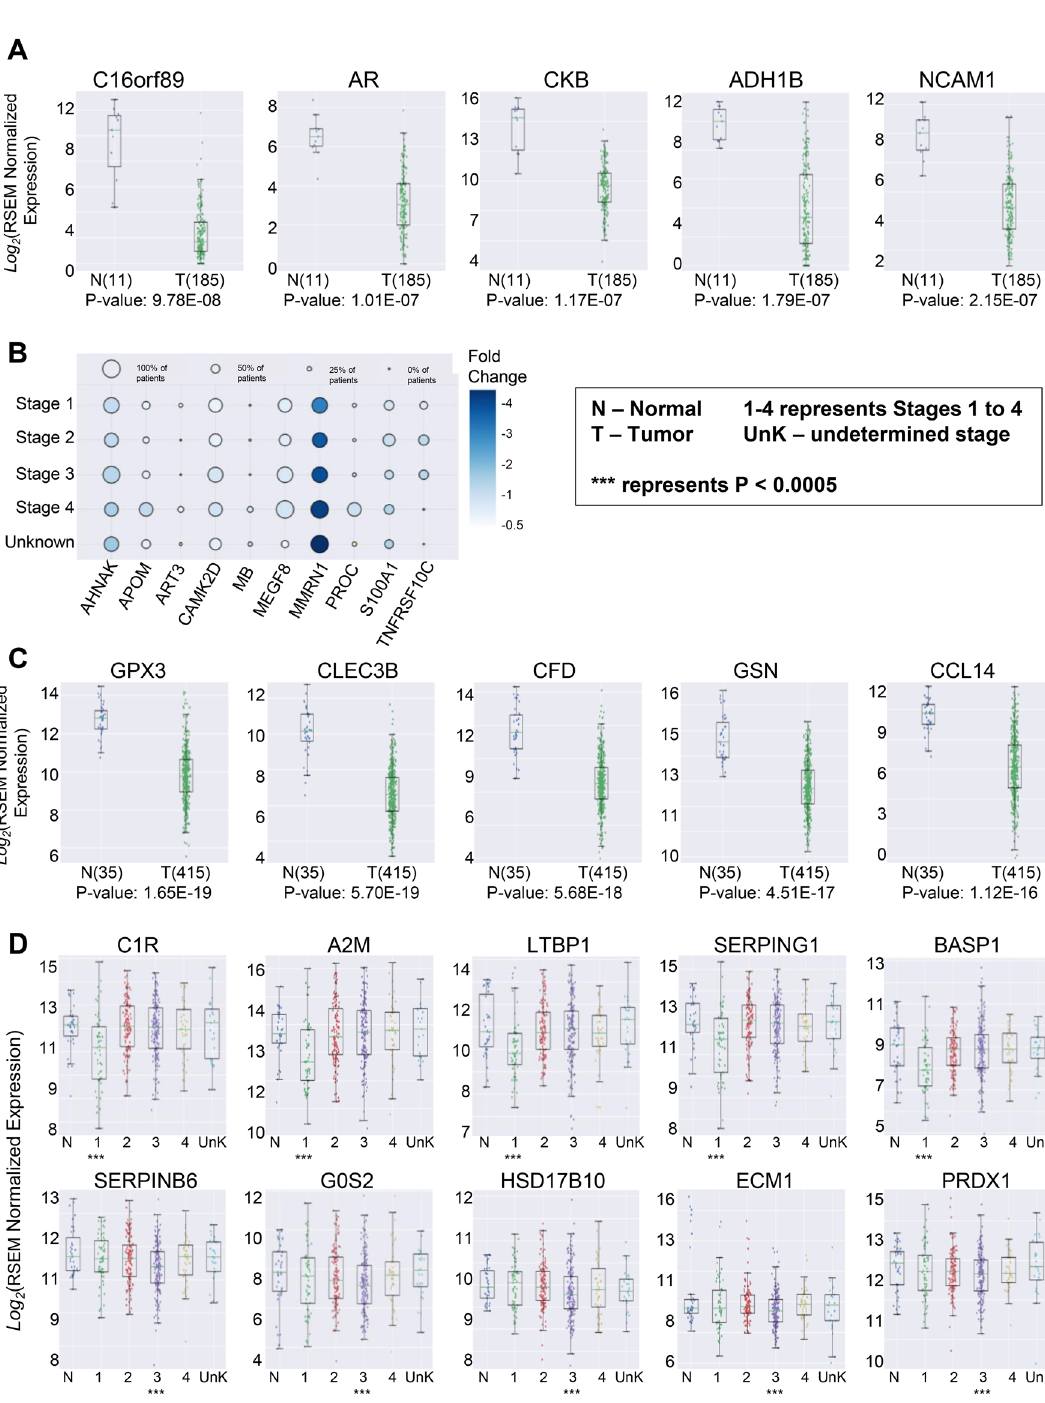
Figure 4. ( A ) Comparison between healthy control and patients with esophageal cancer showed that C16orf89, AR, CKB, ADH1B, and NCAM1 were the top five genes that were significantly down regulated in patients with esophageal cancer. ( B ) Stage-wise incremental downregulation of leading genes in patients with esophageal cancer. ( C ) Comparison between healthy control and patients with stomach cancer showed that: GPX3, CLEC3B, CFD, GSN, and CCL14 were the top five genes that were significantly down regulated in patients with stomach cancer. ( D ) The stage-based analysis showed a differential downregulation of various genes based on the stage of the disease. ( E ) Stage-wise incremental downregulation of leading genes in patients with stomach cancer. ( F ) Stage-wise downregulation of leading genes in patients with stomach